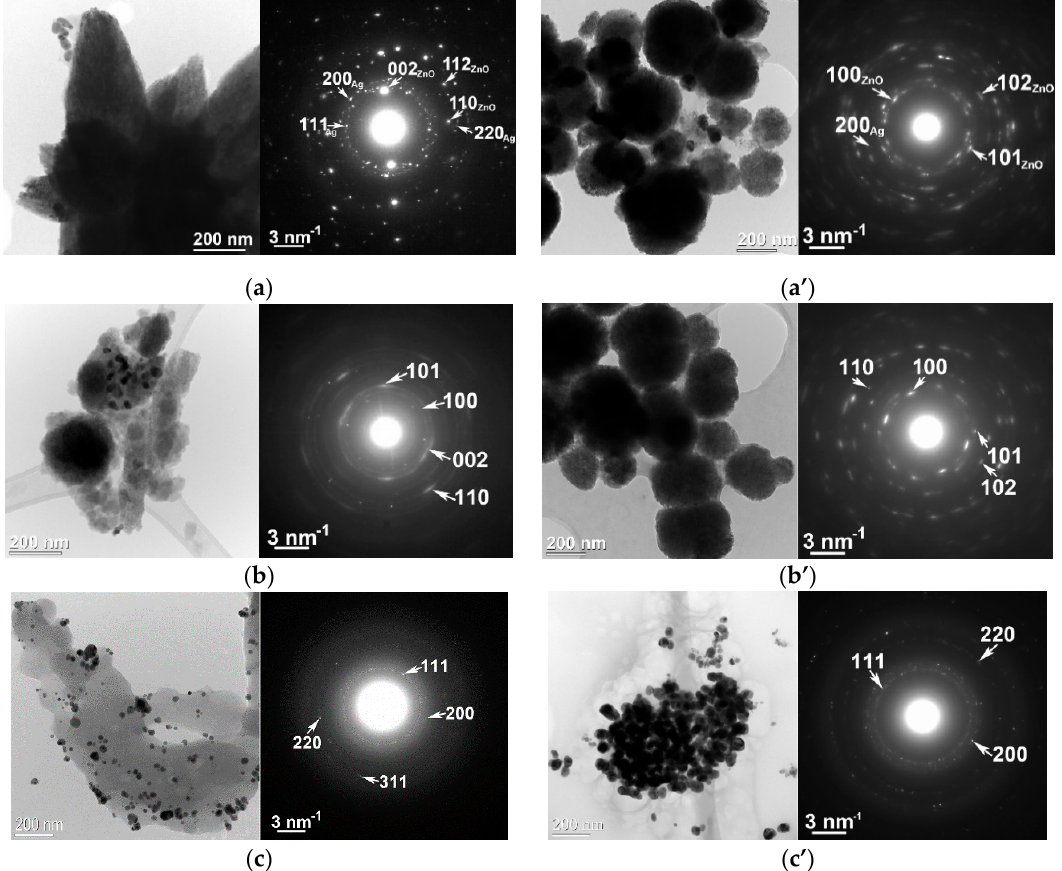
Figure 3. Scanning transmission electron microscopy-high angle annular dark field (HAADF-STEM) images and SAED diagrams for ( a ) AgZnO-CUI, ( b ) ZnO-CUI, ( c ) Ag-CUI, ( a’ ) AgZnO-MAND, ( b’ ) ZnO-MAND and ( c’ ) Ag-MAND.